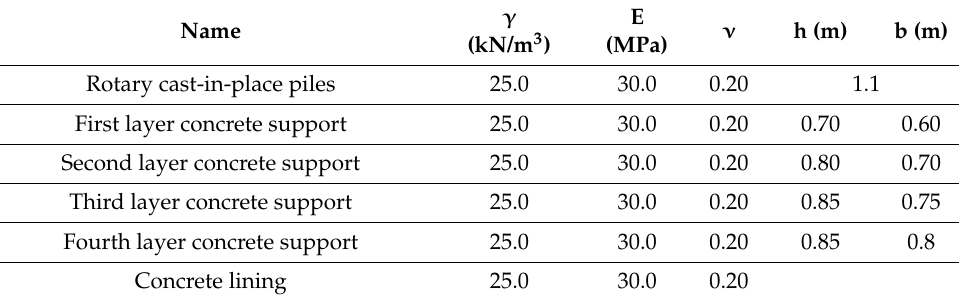
Table 3. Physical and mechanical parameters of concrete members in finite element